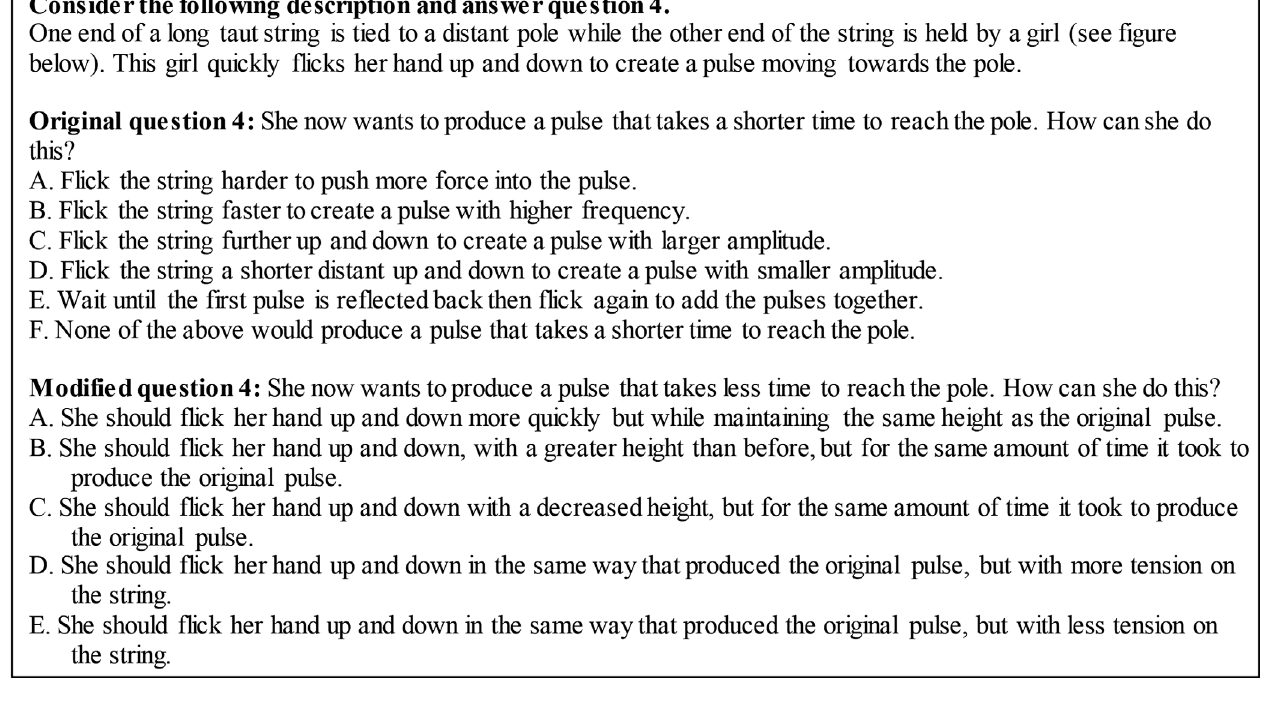
FIG. 2. Original and modified versions of question 4.